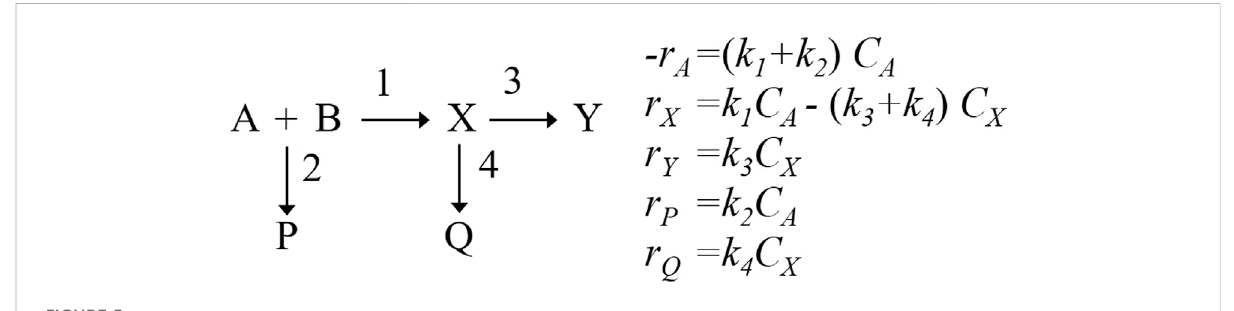
FIGURE 5 Denbigh reactions and their reaction rate equations.